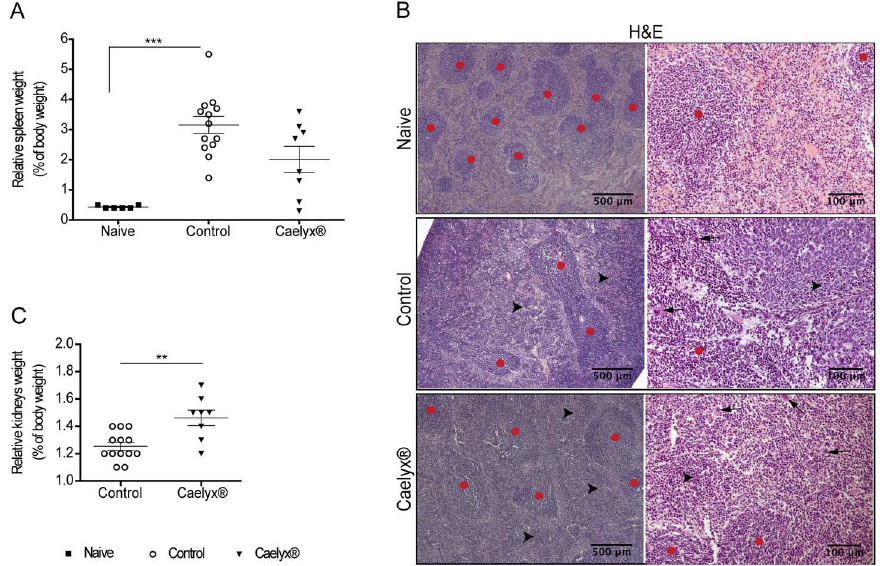
Fig 6. Effect of Caelyx ® in the spleen and kidneys of mice bearing 4T1 tumors. Relativeweight (A) and representative H&E images, originalmagnificationx50 (left) or x200 (right) (B) of spleens from naive mice and mice treated with Caelyx ® or saline (control). Images illustrate the red pulp markedly expandedby numerous hematopoietic cells (black arrowheads), includingmegakaryocytes (black arrows), and myeloid precursor cells, particularlyin the controls. Red circles represent white pulp areas with lymphoidnodules. The relative weight of kidneys (C) from Caelyx ® - or saline-treated control mice was also analyzed. *** , p < 0.001, nonparametric one-way ANOVA with Dunn’s multiple comparisons test; ** , p < 0.01, two-tailed nonparametric Mann-Whitney